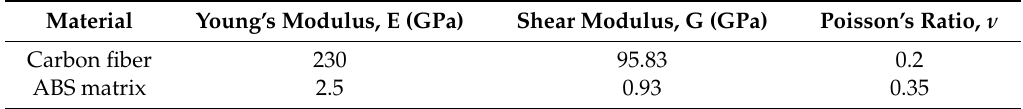
Table 2. Elastic properties of the fiber and the matrix of the